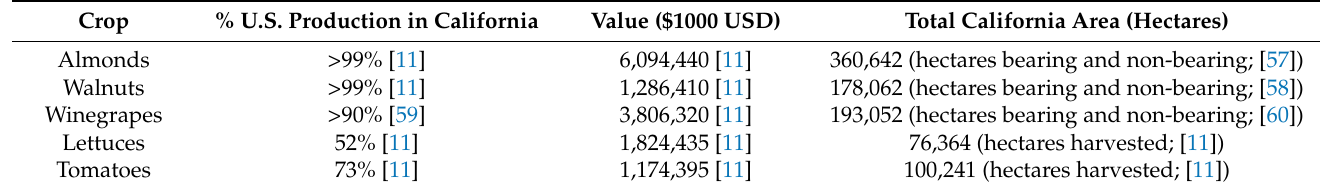
Table 2. Five high-value example crops, the percent of U.S. production occurring in California, the total value of each crop based on crop receipts for California producers, the total acreage in the state, the top three California counties by acreage, based on the